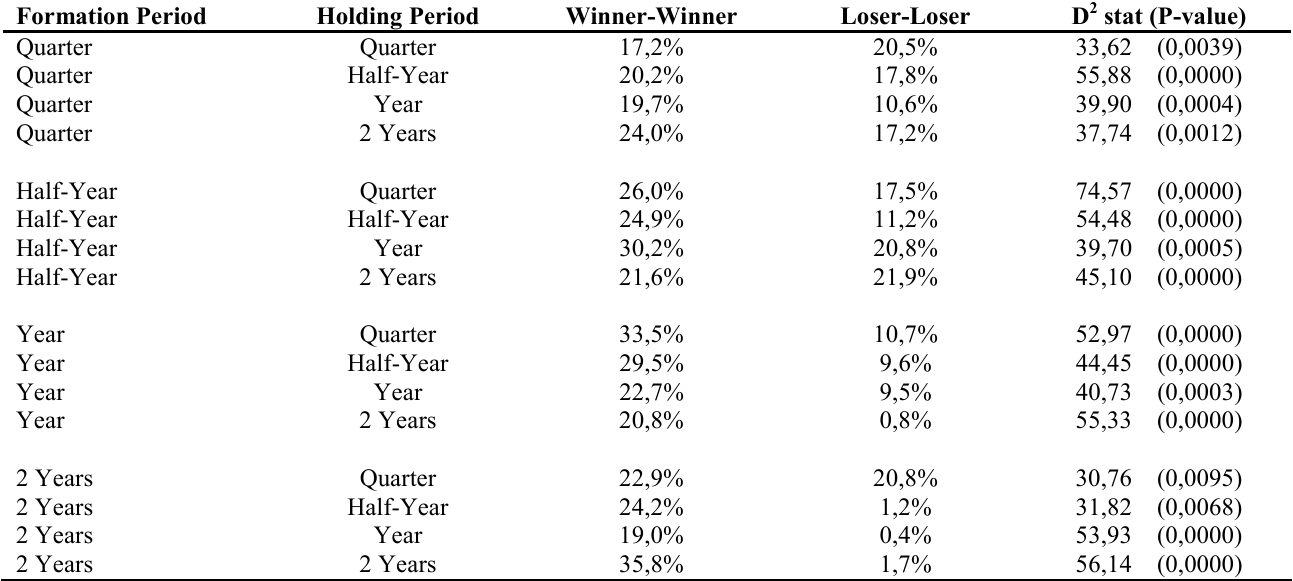
Table 4: The percentage of persistence in the risk-adjusted quartile table explained by winner-winners and loser-losers Formation Period